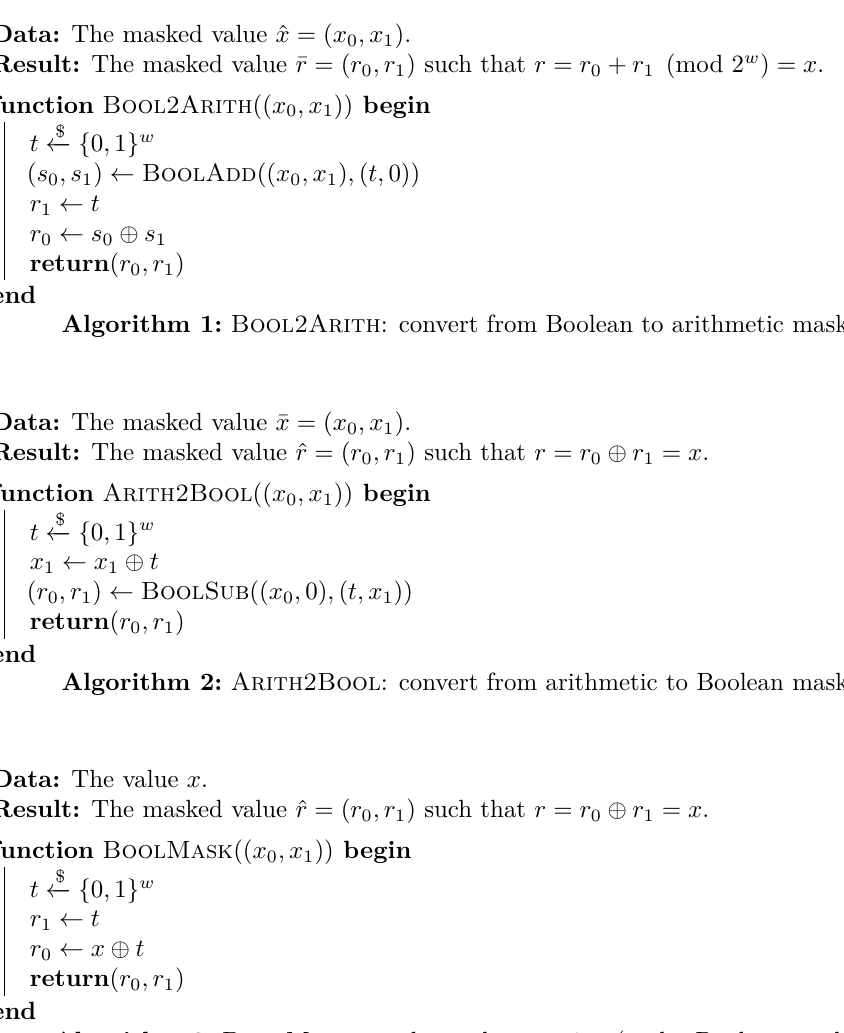
Algorithm 3: BoolMask : apply mask operation (under Boolean